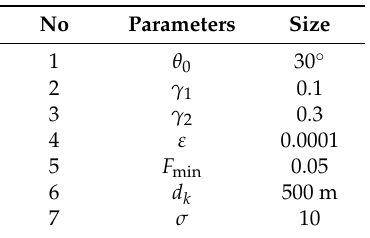
Table 1. Setting navigation